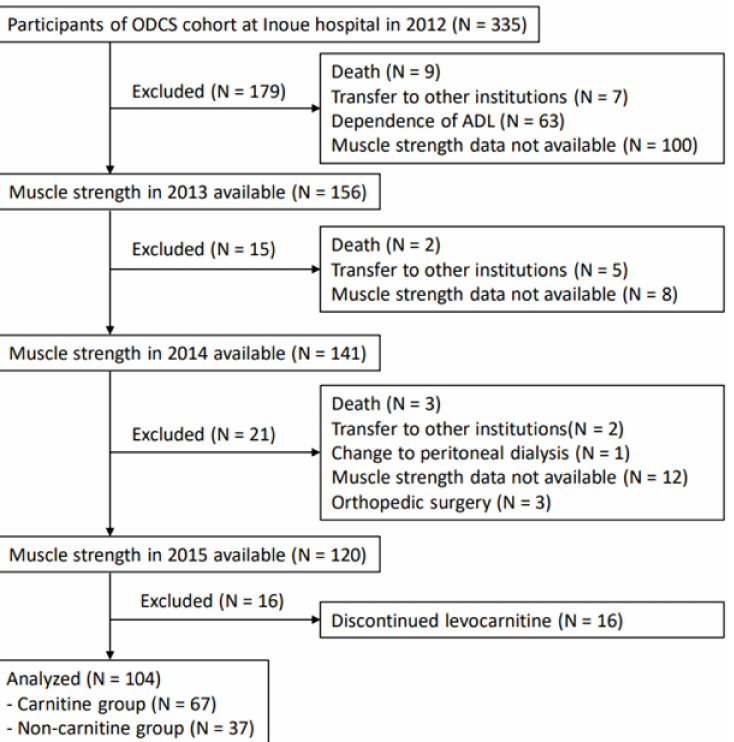
Figure 1. Selection of study participants. The patients analyzed in this study were selected from the 335 participants of the Osaka Dialysis Complication Study treated at Inoue Hospital. According to the inclusion and exclusion criteria, 104 eligible patients were included. Abbreviation: ODCS, Osaka Dialysis Complication Study; ADL, activity of daily living.